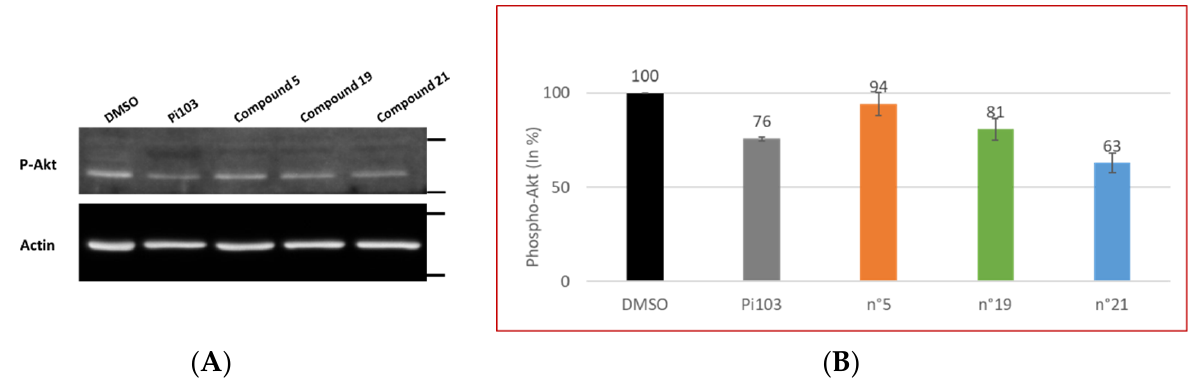
Figure 6. ( A ) Effects of Pi103 and compounds 5 , 19 and 21 on Akt phosphorylation (T308) in Caco-2 cells at 1 μ M by Western blotting. ( B ) Quantification of three independent experiments. The values obtained for P-Akt were first normalized with actin and then normalized to 100%.